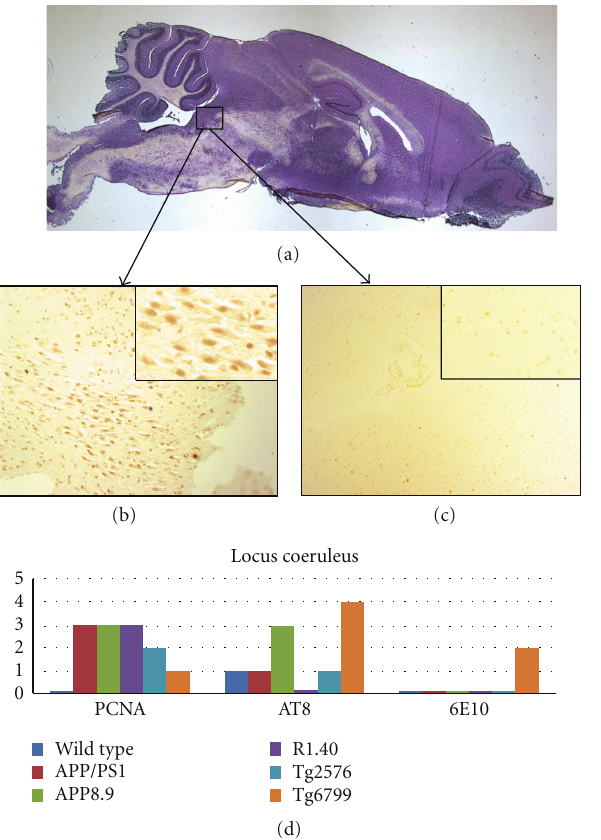
Figure 1: Comparison among the mouse lines studied with respect to the presence of cell cycle events (PCNA), tau-phosphorylation (AT8), and beta-amyloid plaque deposition (6E10) in the locus coeruleus. (a) Sagittal section of a wild-type mouse brain indicating the approximate location of the locus coeruleus. (b) PCNA-positive neurons are illustrated by their appearance in this representative section from the APP8.9 mouse model. (c) Minor PCNA immunos- taining is seen in wild-type mice as illustrated in this representative micrograph. (d) Quantification of the extent of immunostaining for the cell cycle, phospho-tau, and beta-amyloid plaques in the five transgenic models plus wild type.